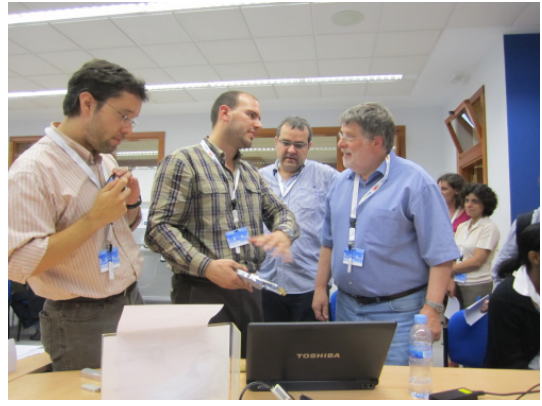
Figure 6. LipoTool – REV2012 Exhibition